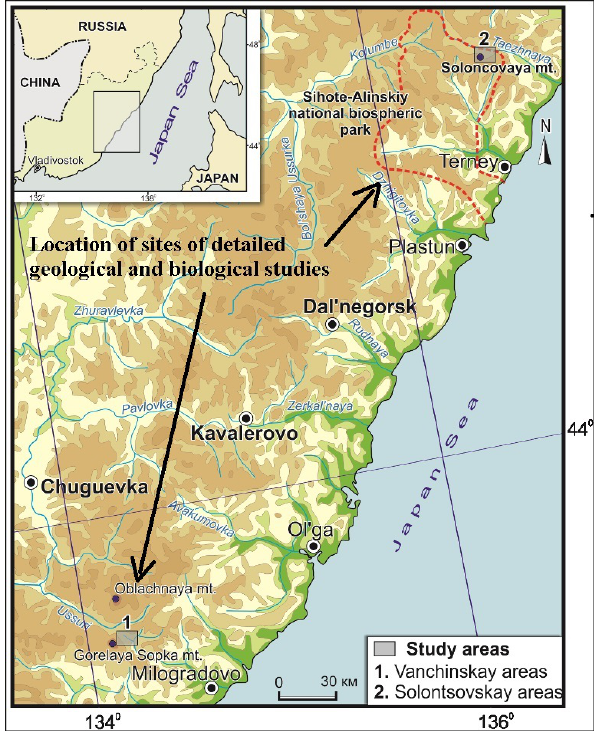
Figure 1. Location of sites of detailed geological and biological studies around the Vanchinsky coal-bearing basin (area no. 1) and in the area of the Solontsovsky palaeovolcano (area no.